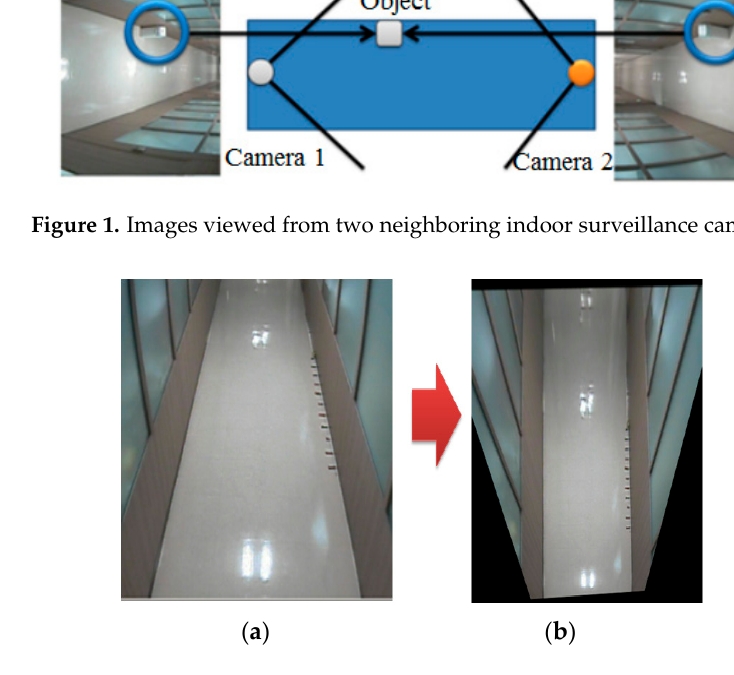
Figure 2. ( a ) Original image; ( b ) Air view image of ( a ).